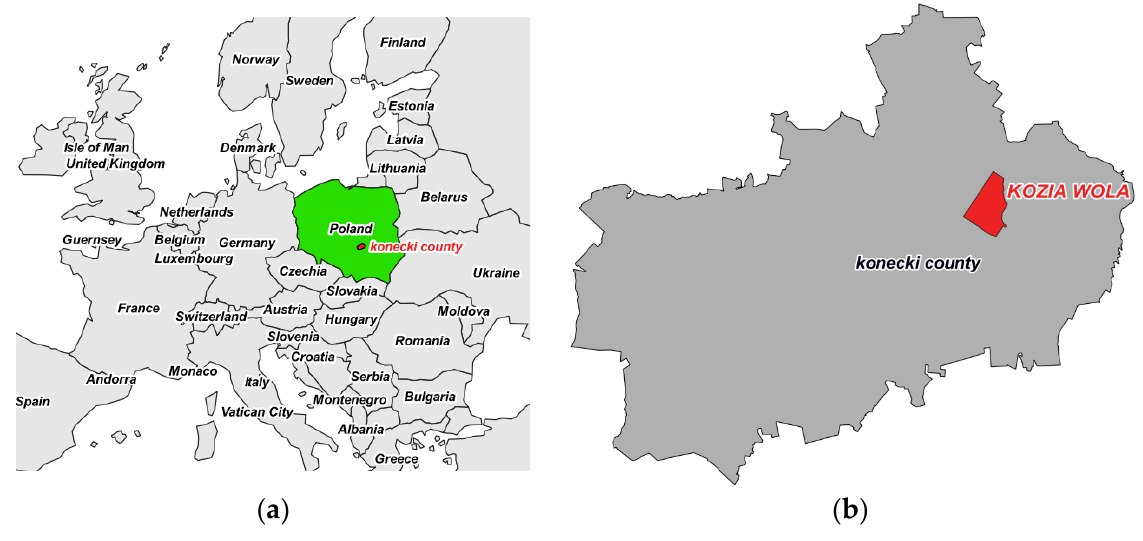
Figure 2. Location of the analysed area, ( a ) general location, ( b ) detailed location.